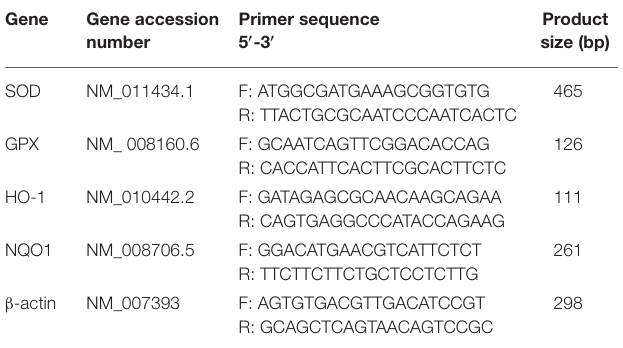
TABLE 2 | RT-PCR primer sequences.